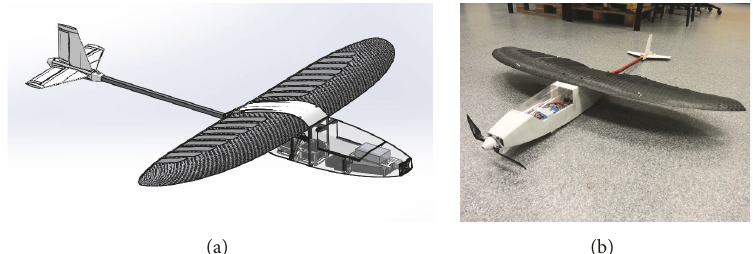
Figure 3: Design of the FMW mini-UAV and the final prototype: (a) 3D CAD model of the FMW mini-UAV; (b) 3D printed fuselage of the FMW mini-UAV. Carbon fiber rod is used for the tail